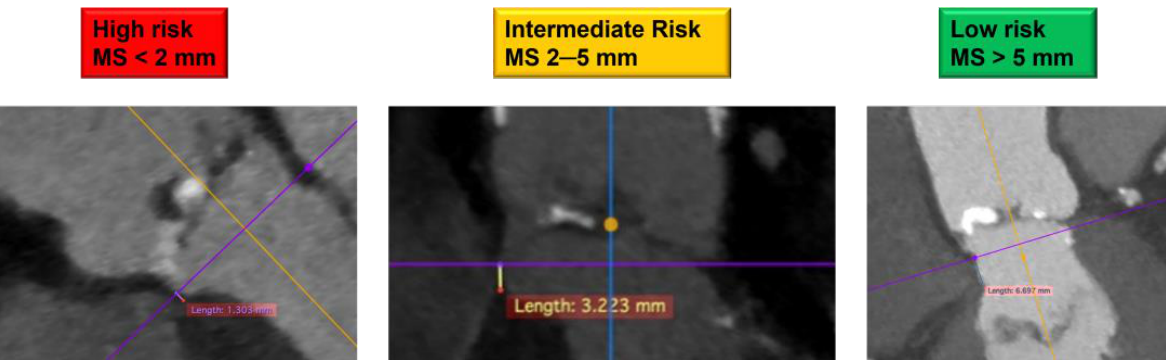
Figure 4. The impact of membranous septum (MS) length on permanent pacemaker implantation. Hamdan et al. found that the difference between MSL and implantation depth